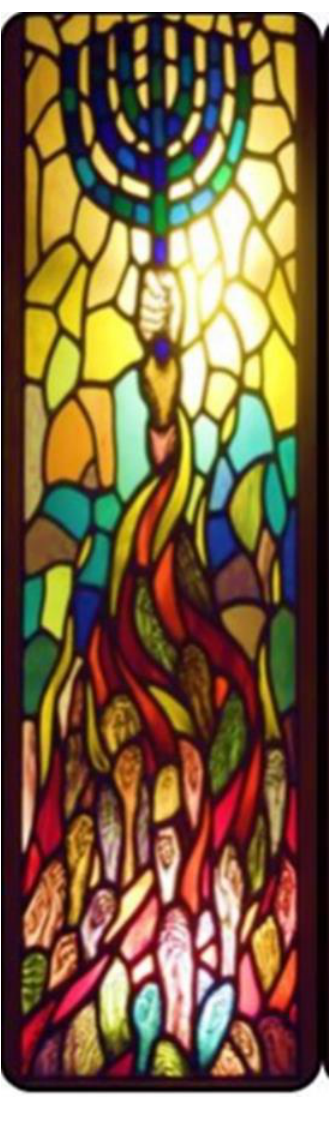
Figure 1: Glass artefact in Bitachon. Photograph by the